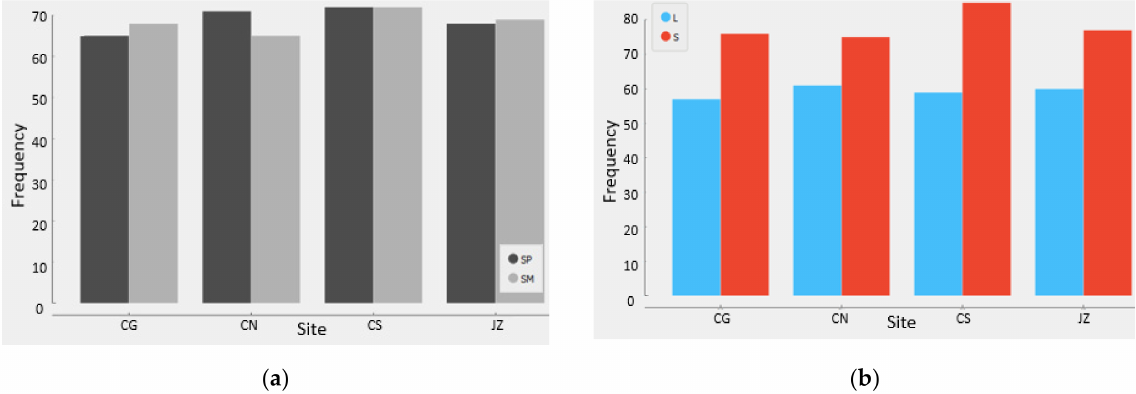
Figure A2. Histograms of distribution of µ XANES obtained: ( a ) Divided by season (SP-Spring, SM-summer); ( b ) Divided by size (L-Large, S-Small), there are Smaller since all µ XANES from water extraction samples are included in this category.